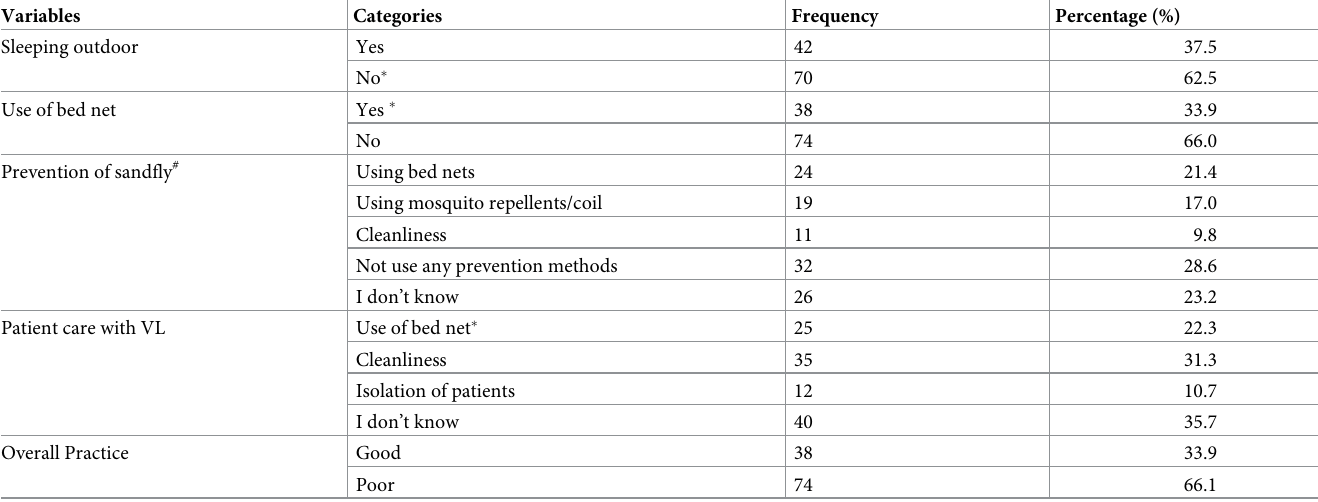
Table 6. Practices toward the control and prevention of VL among the study participants (N =